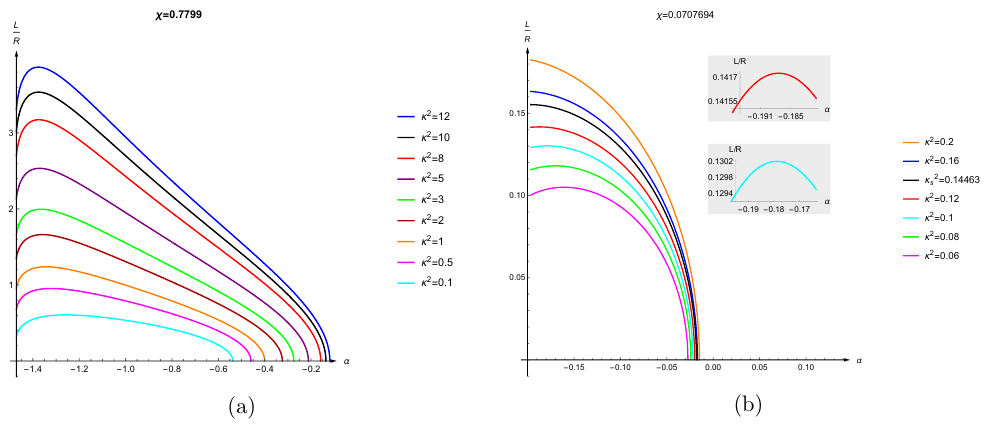
Figure 5. We have plotted the distance L as a function of (cid:11) = arctan( m ). In (a) we have chosen an angle (cid:31) > (cid:31) s : the di(cid:11)erent curves corresponds to di(cid:11)erent values of the (cid:13)ux. All the curves display a maximum. In (b) we have chosen an (cid:31) < (cid:31) s . When we are above the critical (cid:13)ux (cid:20) > (cid:20) s (the black curve), the curves are monotonic. On the contrary, as (cid:20) becomes smaller than (cid:20) s (i.e. we are below the black curve) again a maximum